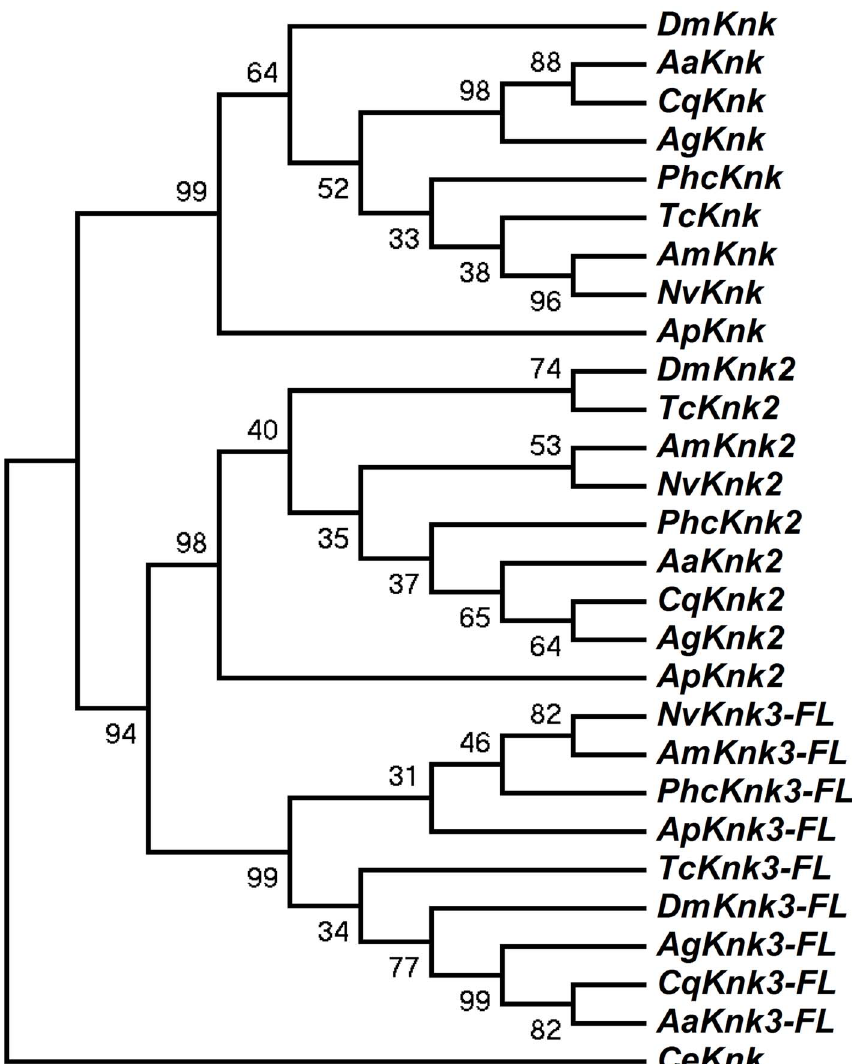
Figure 3. Phylogenetic analysis of insect TcKnk2 and TcKnk3. Protein sequence predicted from the TcKnk3- full length transcript without exon 8a was used for analysis. MEGA 4.0 was used to construct the phylogenetic tree using the neighbor joining method [16]. Bootstrap analyses from 5000 replications are shown by each branch. Drosophila melanogaster (fruit fly) (Knk2, NP_001097889.2; Knk3, NP_001027171.1); Anopheles gambiae (African malaria mosquito) (Knk2, XP_308115.4; Knk3, XP_313250.2); Aedes aegypti (yellow fever mosquito) (Knk2, XP_001657415.1; Knk3, XP_001657668.1); Culex quinquefasciatus (southern house mosquito) (Knk2, XP_001845444.1; Knk3, XP_001864909.1); Pediculus humanus corporis (head louse) (Knk2, XP_002429468.1; Knk3, XP_002425509.1); Tribolium castaneum (red flour beetle) (Knk2, XP_973211.1; Knk3, XP_968712.2); Apis mellifera (honey bee) (Knk2, XP_393508.4; Knk3, XP_003250319.1); Nasonia vitripennis (parasitic wasp) (Knk2, XP_001602771.1; Knk3, XP_001606495.2) and Acyrthosiphon pisum (pea aphid) (Knk2, XP_001946688.2; Knk3, XP_003241759.1); Caenorhabditis elegans (roundworm)